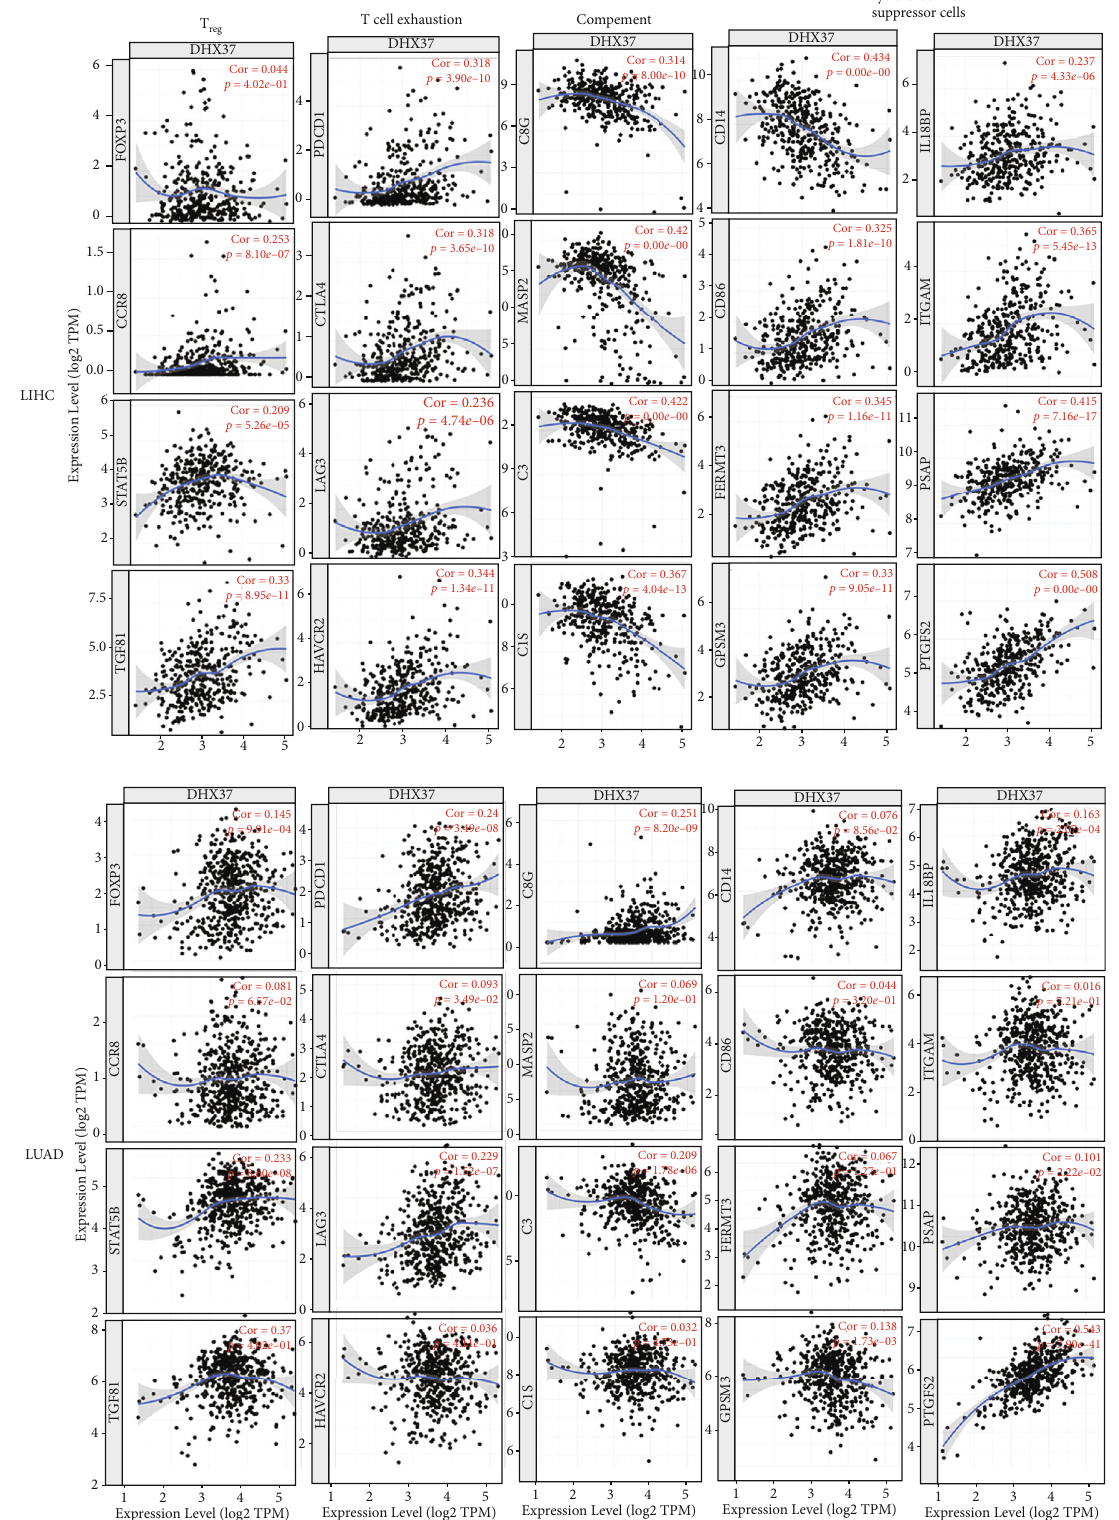
Figure 6: DHX37 expression correlates with T , T cell exhaustion, complement, and myeloid-derived suppressor cells in LIHC and LUAD. regs Markers include FOXP3, CCR8, STAT5B and TGFB1 of T , PDCD1, CTLA4, LAG3 of HAVCR2 of T cell exhaustion, CD14, CD86, regs FERMT3, GPSM3, IL18BP, ITGAM, PSAP and PTGES2 of myeloid-derived suppressor cells, C8G, MASP2, C3, and C1S of complement. P < 0 : 05 is considered signi fi